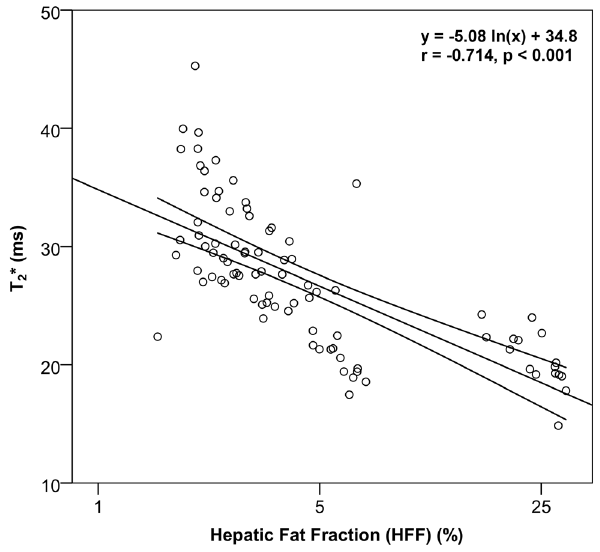
Figure 3. Regression plot between HFF and T 2 *. The correlation between HFF (%) and T 2 * (ms) was assessed by using a log-linear model. Pearson’s product-moment correlation and its significance were calculated. The log-linear regression line is displayed together with its 95% confidence interval.